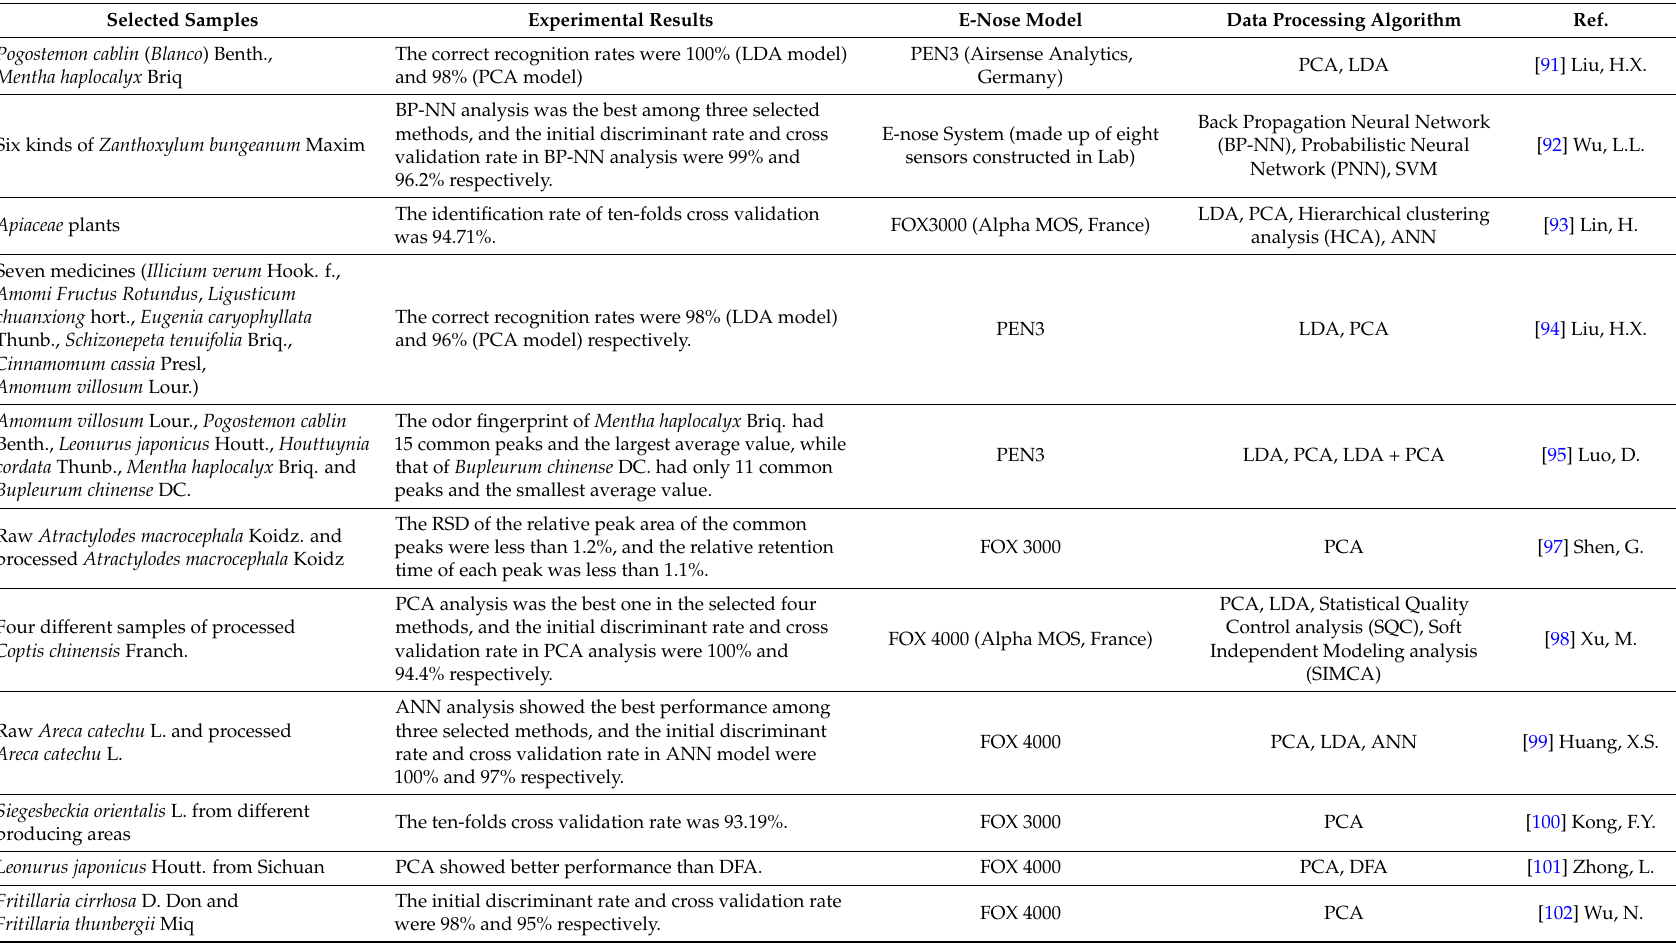
Table 6. Main applications of E-nose systems for CHMs identification and